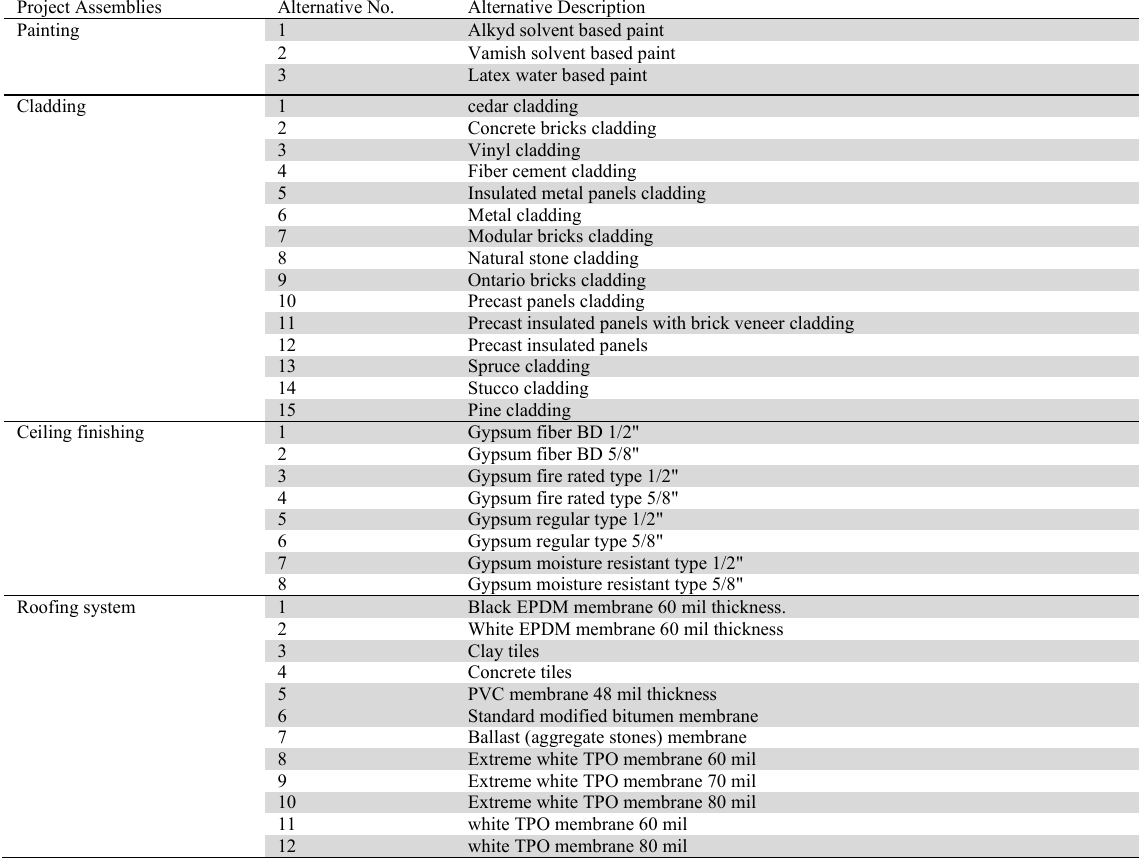
Available alternatives of the case study (Continued) Project